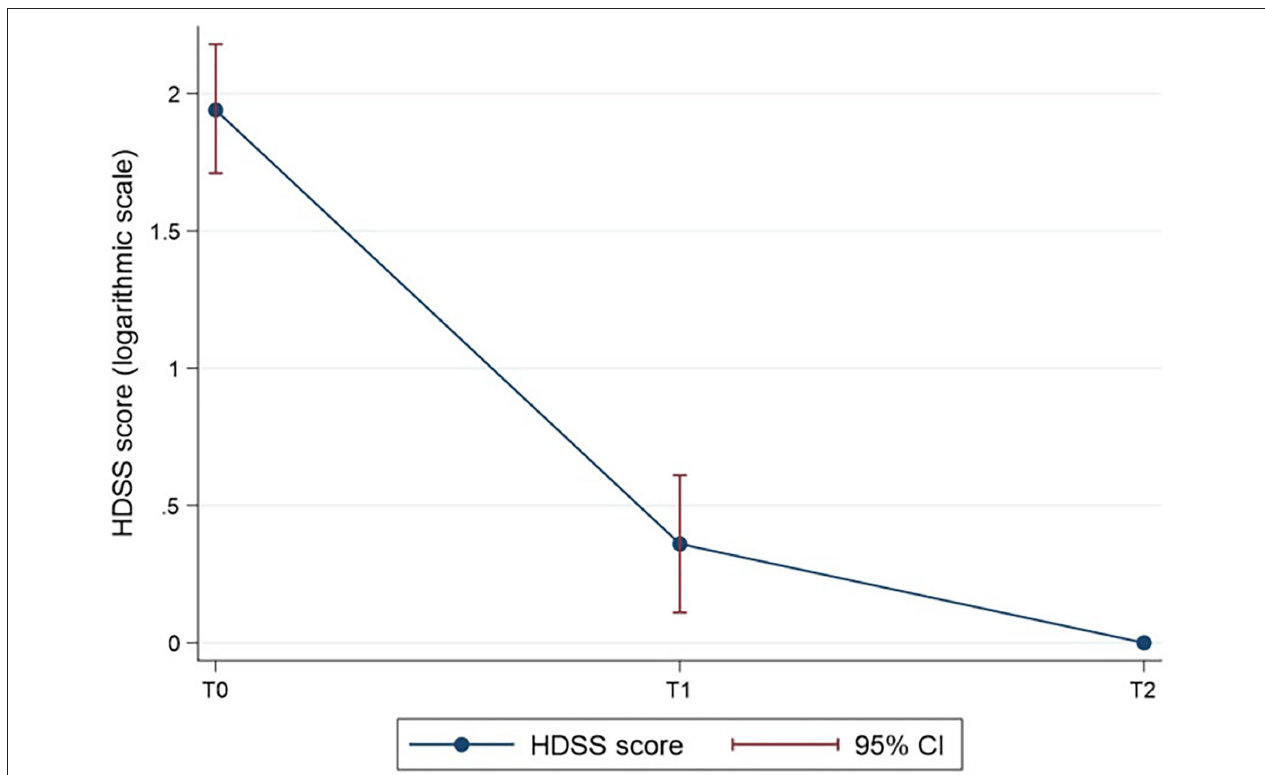
FIGURE 2 | The HDSS score over time (log-transformed for normalisation of the HDSS score data). P < 0.001 for T1 vs. T0 and T2 vs. T0.